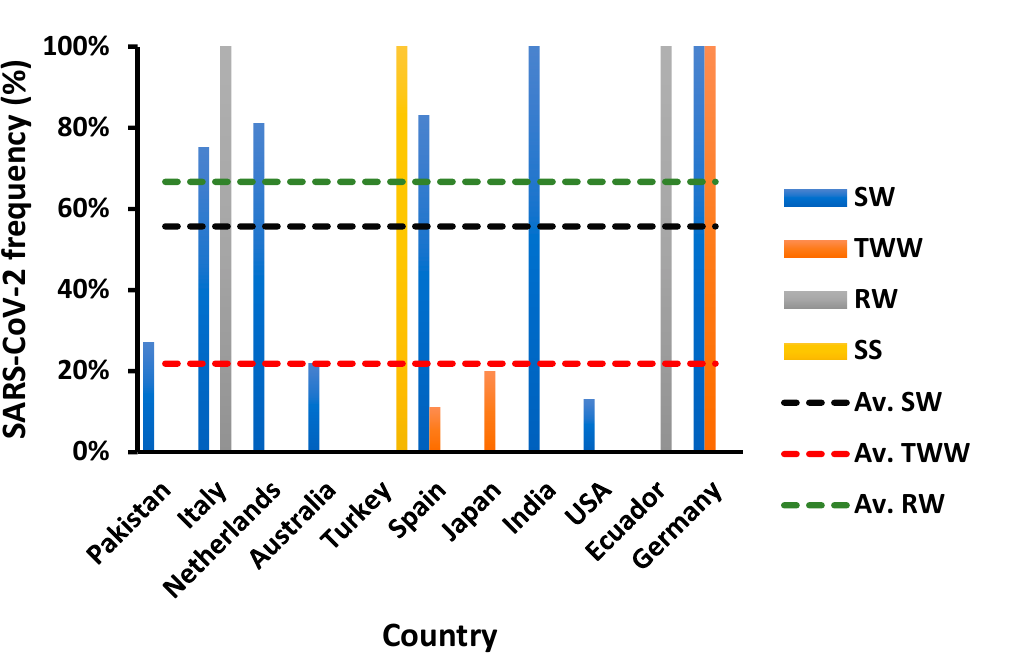
Figure 4. Frequency of SARS-CoV-2 RNA in various water environments [274,276–278,281–286,291]. SW: sewage water, TWW: Treated wastewater, RW: River water, SS: Wastewater sludge samples, Av.: Average frequency, for example, Av. SW: Average frequency of SARS-CoV-2 RNA in SW of countries that involved SW in their evaluation.